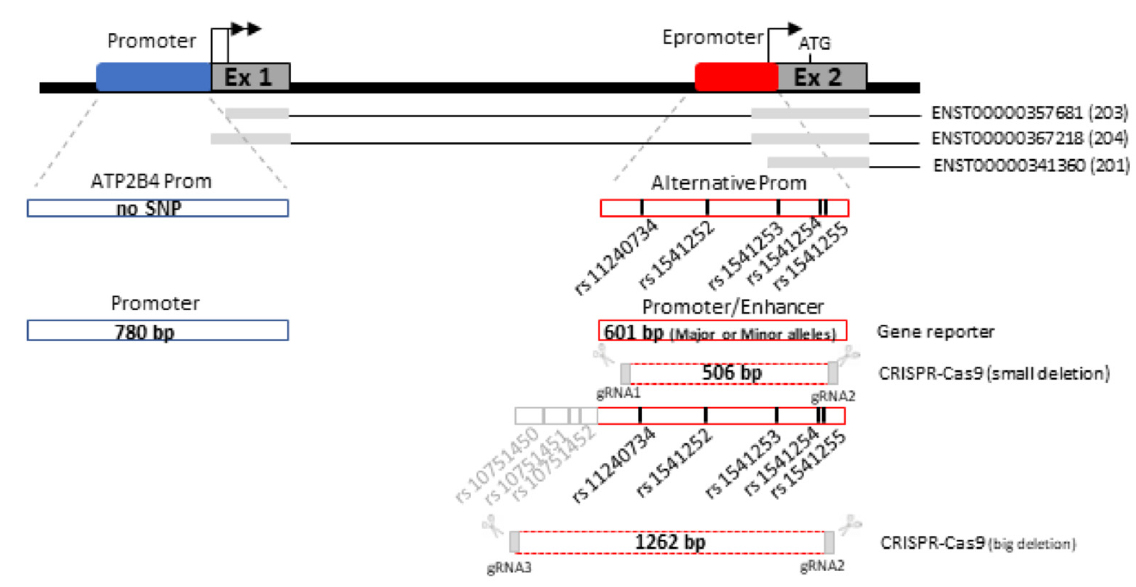
Figure 5. Description of the genomic regions used or deleted for luciferase gene reporter assay and CRISPR-Cas9 genome editing, respectively. The main ATP2B4 promoter is illustrated in blue, whereas the alternative promoter containing the five SNPs studied is illustrated in red. For the luciferase gene reporter assay, the 601 bp genomic region was cloned first into the promoter position in pGL3-basic vector with the minor or major alleles, and then into the enhancer position in pGL3- Enhancer vector using the 780 bp genomic region as a promoter. For CRISPR-Cas9 editing a 506 bp fragment containing the five SNPs was deleted using gRNA1 and gRNA2. We also deleted a larger region containing eight SNPs (our five SNPs and three SNPs studied by Lessard et al.) using gRNA3 and gRNA2.